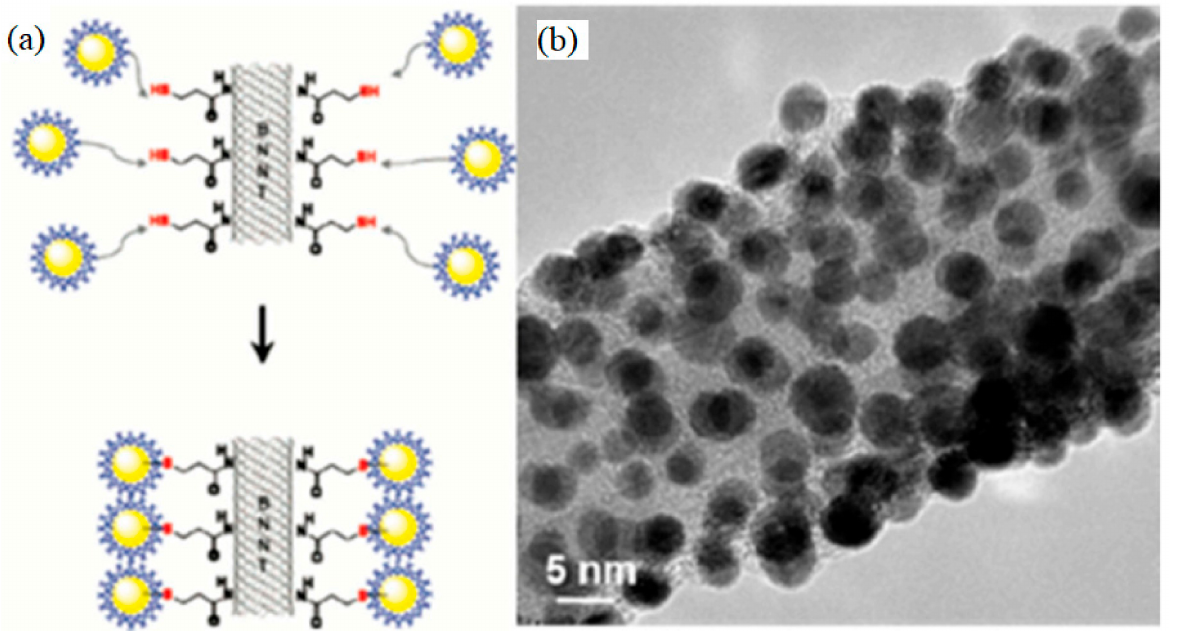
Figure 8. ( a ) Schematic representation of the synthesis, by Au NPs, of the NTs of Thiol pendant groups functioning decorative boron nitrid, ( b ) the relevant TEM picture, reproduced with a reference authorization, ACS, 2004 [78].